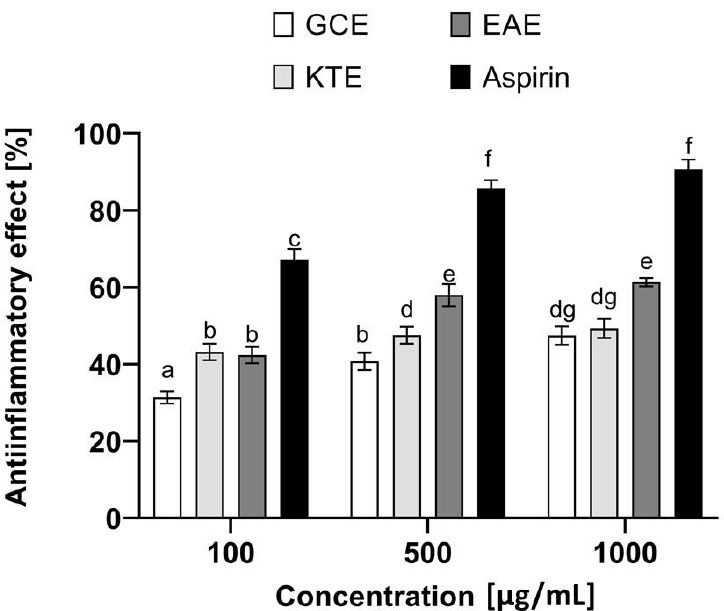
Figure 16. Anti-inflammatory effect of Centella asiatica L. (GCE), Clitoria ternatea L. (KTE) and Epilobium angustifolium L. (EAE) extracts. Data are the mean ± SD of three independent experiments, each of which consists of three replicates per treatment group. Different letters on the charts indicate significant differences between groups ( p < 0.05).